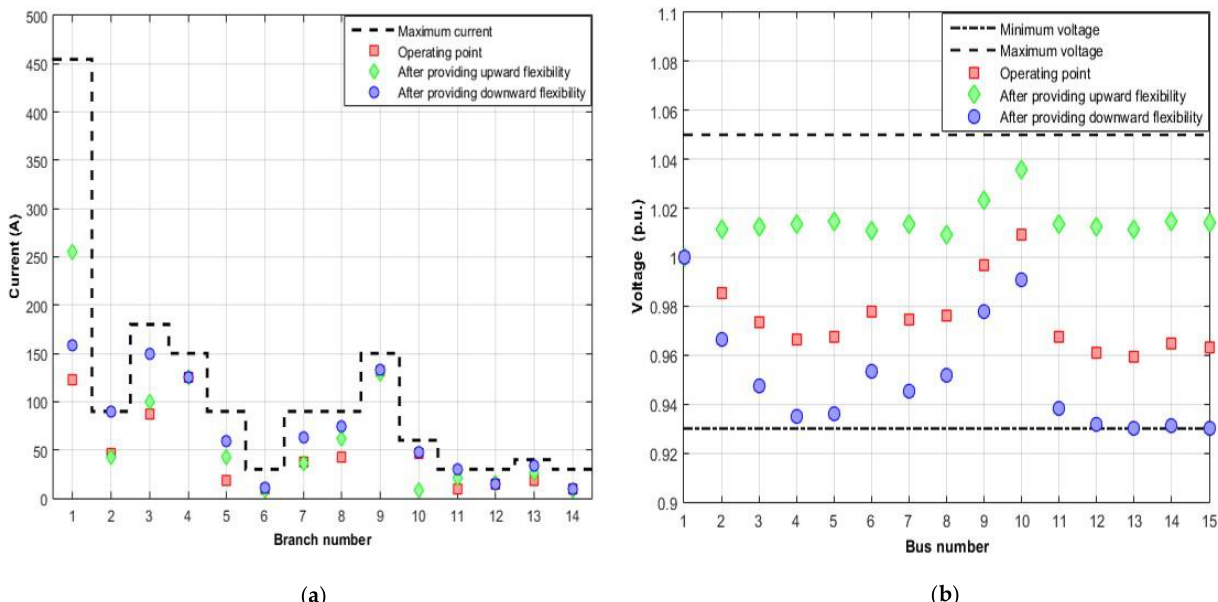
Figure 4. ( a ) Branch currents and ( b ) node voltages for the initial operating point and after providing maximum flexibility.